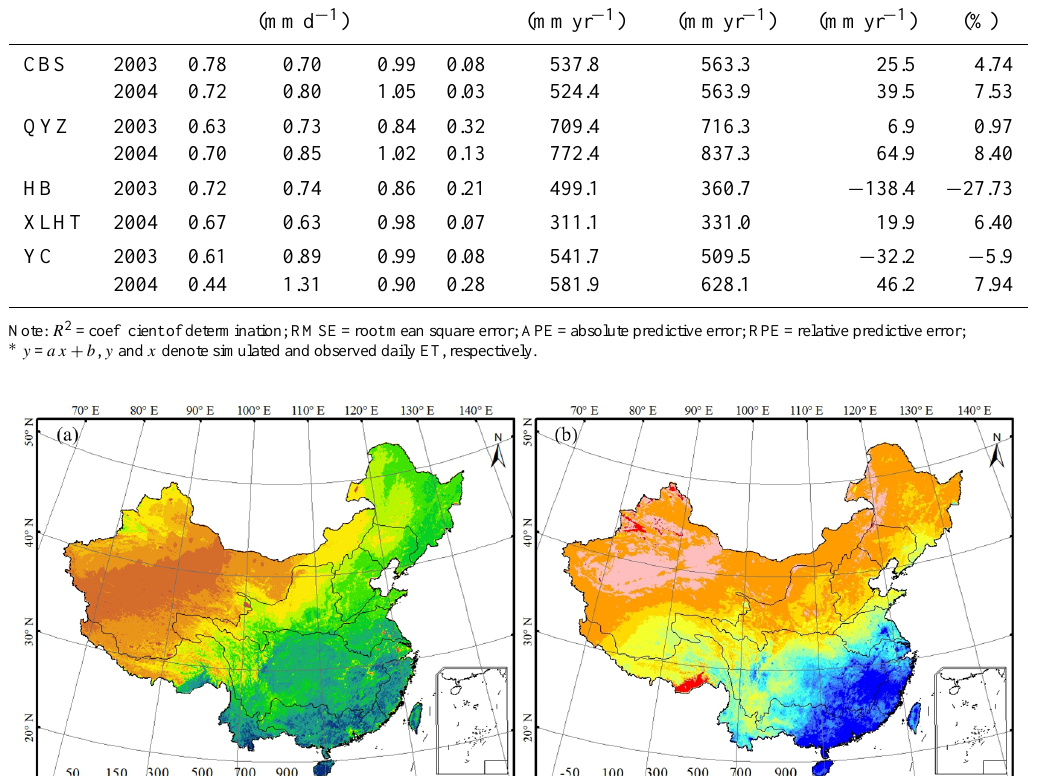
close to 500 mm yr − 1 , in contrast to the arid NWRB,